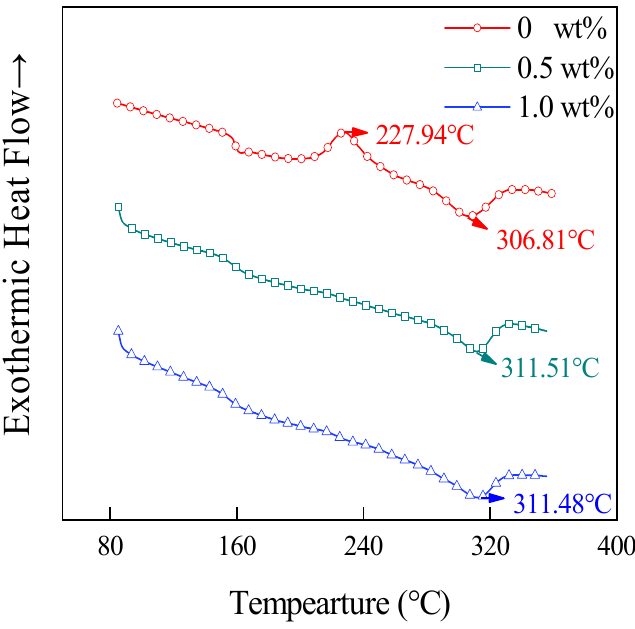
Table 1. T cc , T m , T c , Δ H m , Δ H cc , Χ c and t 1/2 of prepregs with different CNT contents.